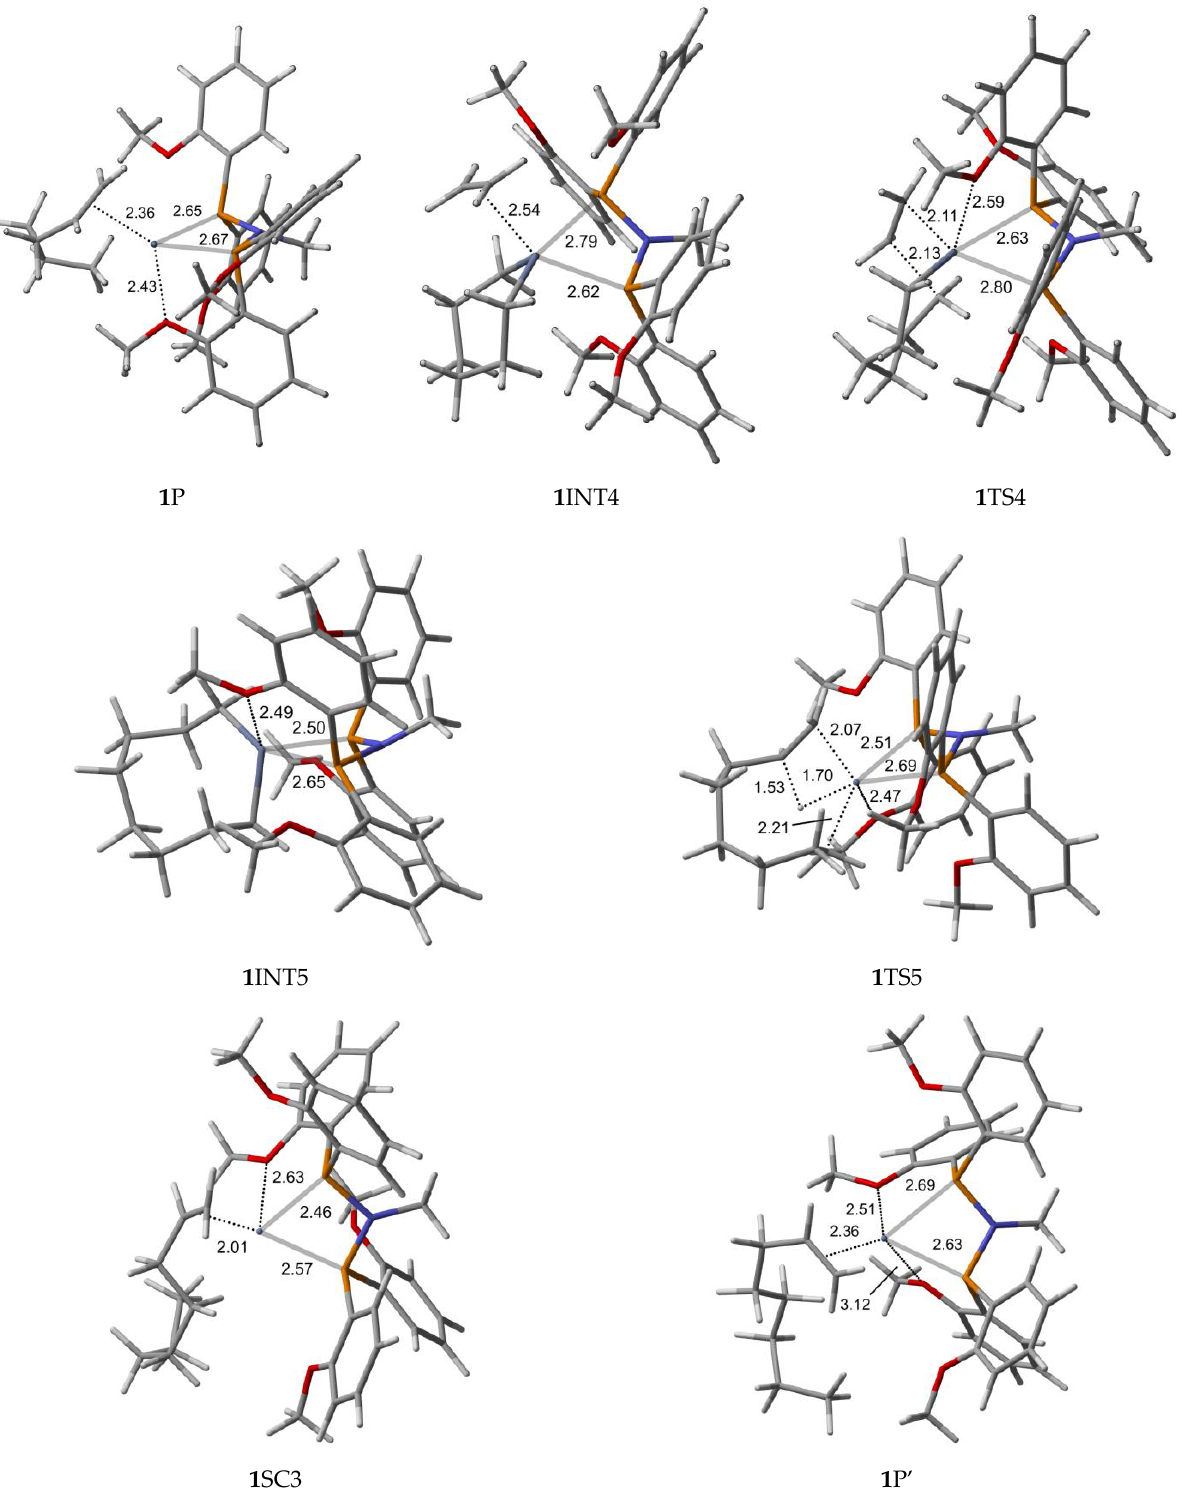
Figure 3. B3LYP/6-31G*/LanL2DZ optimized geometries (Supplementary Material) with important distances (Å) for ethylene trimerization and tetramerization using the ortho -methoxyaryl Cr-PNP catalyst. (Gray: carbon; red: oxygen; white: hydrogen; orange: phosphorus; blue: nitrogen; dark gray: Cr).